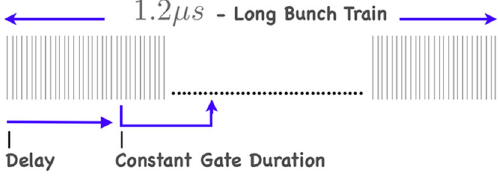
FIG. 9. The illustration of the time-resolved OTR profiling of the electron beam. The scheme as shown in the figure would allow a measurement that is integrated over a region determined by the constant gate duration.